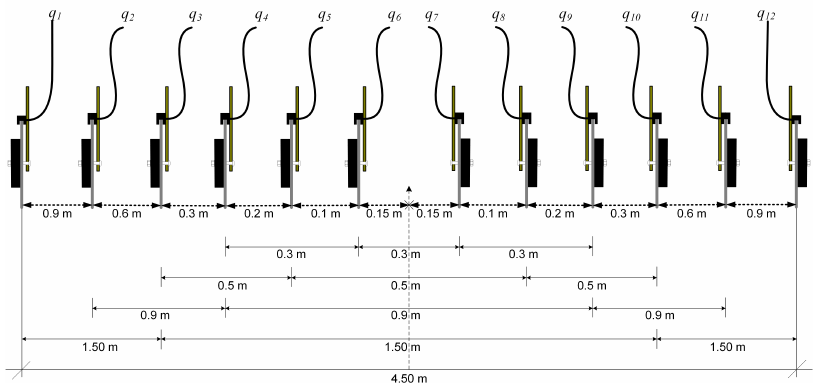
Figure 10. Possible arrangement of disc blades.